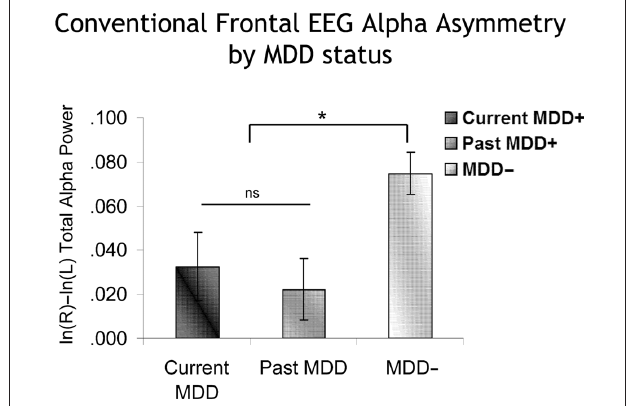
FIGuRE 7 | Conventional frontal alpha asymmetry scores as a function of MDD status. Error bars reflect standard error. Y -axis is ln μV 2 /cm 2 . Both currently and previously depressed individuals had significantly lower asymmetry scores than never-depressed individuals.